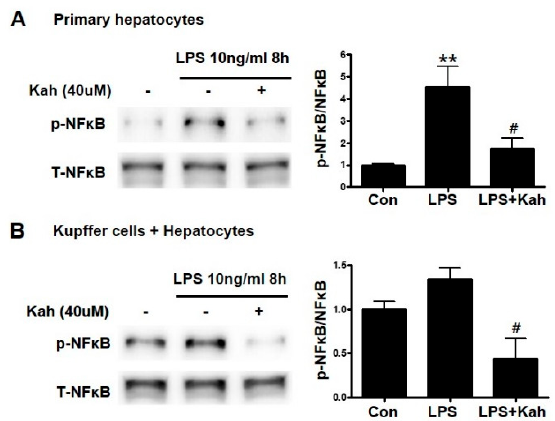
Figure 4. Effect of kahweol on lipopolysaccharide (LPS)-induced activation of the NF κ B pathway. ( A ) Primary hepatocytes were pretreated with kahweol (Kah) and then stimulated with or without LPS. The expression of phosphor (p)-NF κ B was analyzed by western blot. Data represented in the bar graph are the mean ± SEM of three independent measurements. ** p < 0.01 compared with control (Con), # p < 0.01 compared with LPS. ( B ) Co-culture of Kupffer cells with hepatocytes were pretreated with the kahweol and then stimulated with or without LPS. The expression of phosphor (p)-NF κ B were analyzed by western blot. Data represented in the bar graph are the mean ± SEM of three independent measurements. # p < 0.01 compared with LPS. T-NF κ B, total NF κ B.